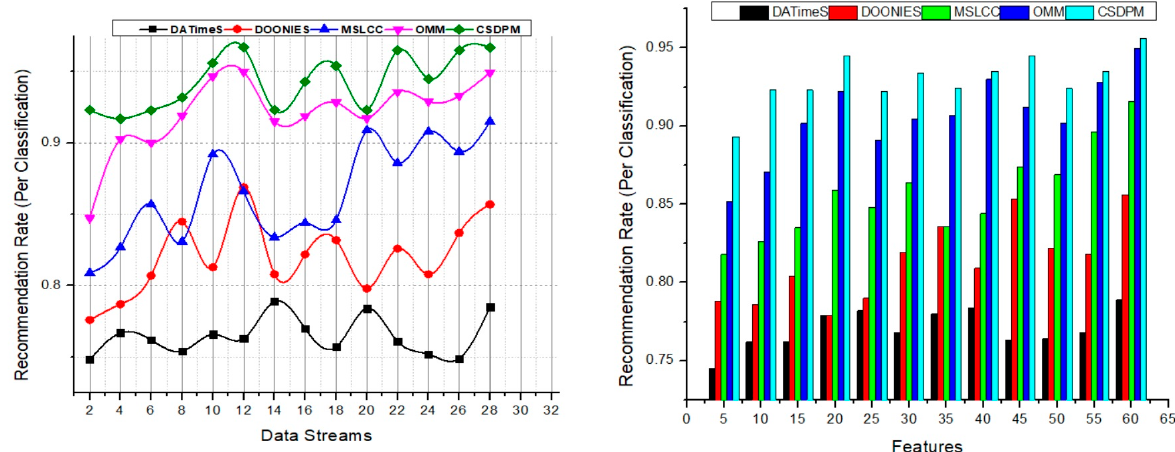
Figure 13. Recommendation rate.